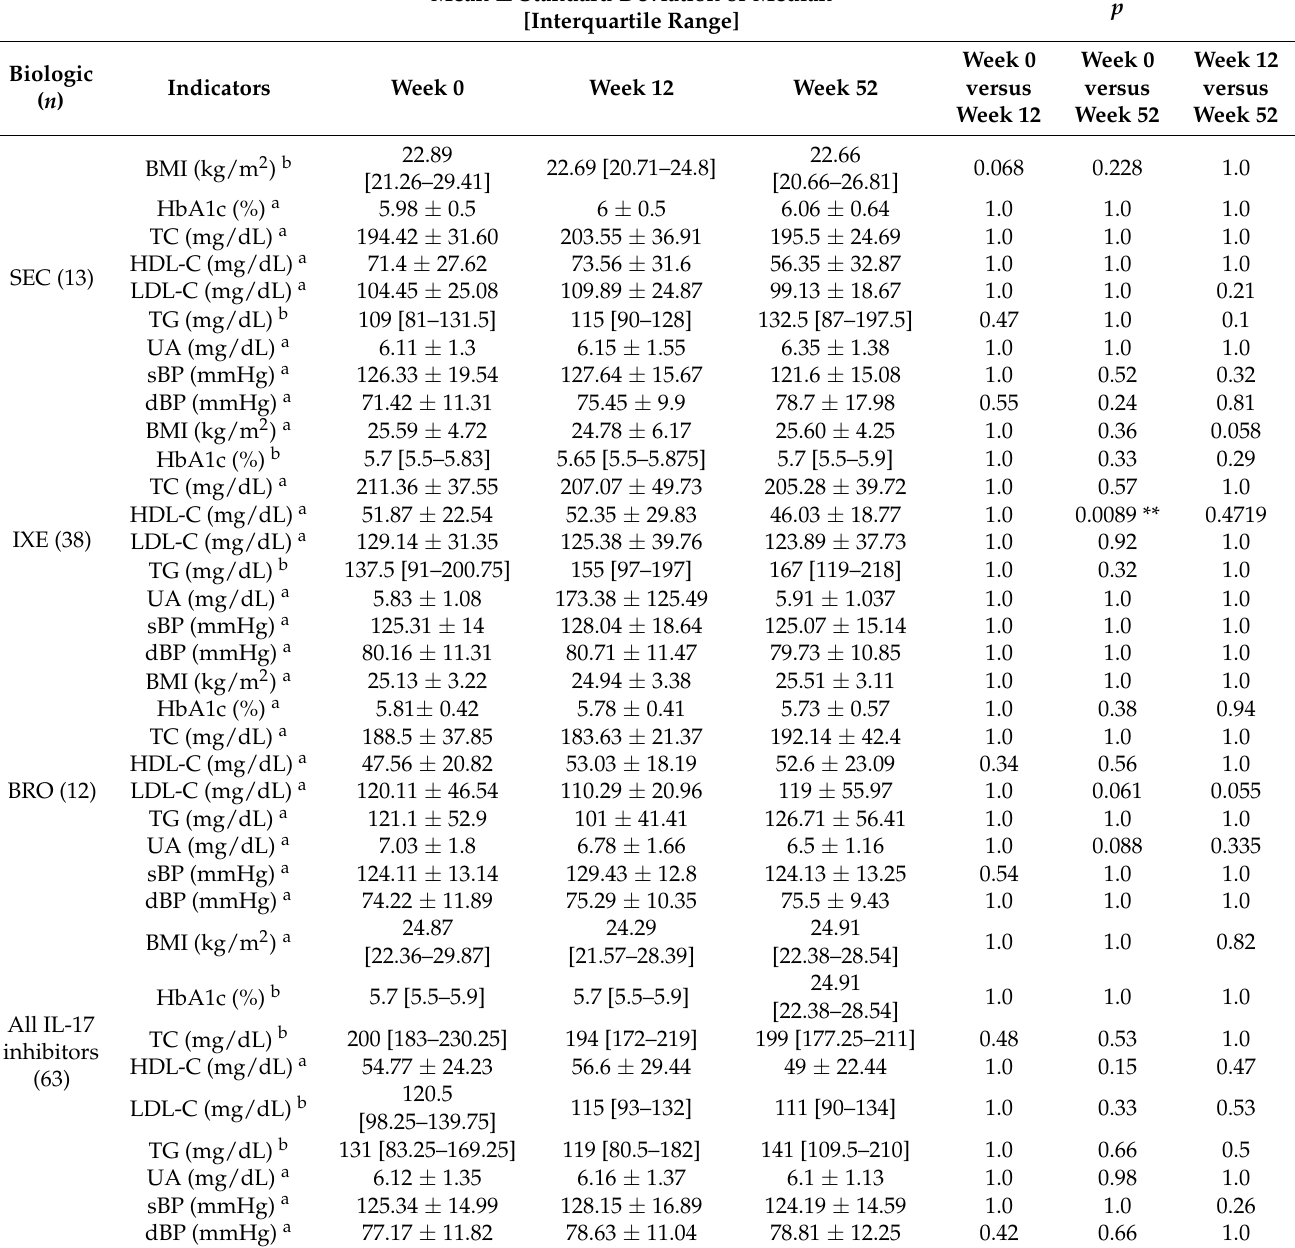
Table 4. The levels of indicators of cardiometabolic diseases at week 0, 12, and 52 of treatment with IL-17 inhibitors. Mean ± Standard Deviation or Median [Interquartile